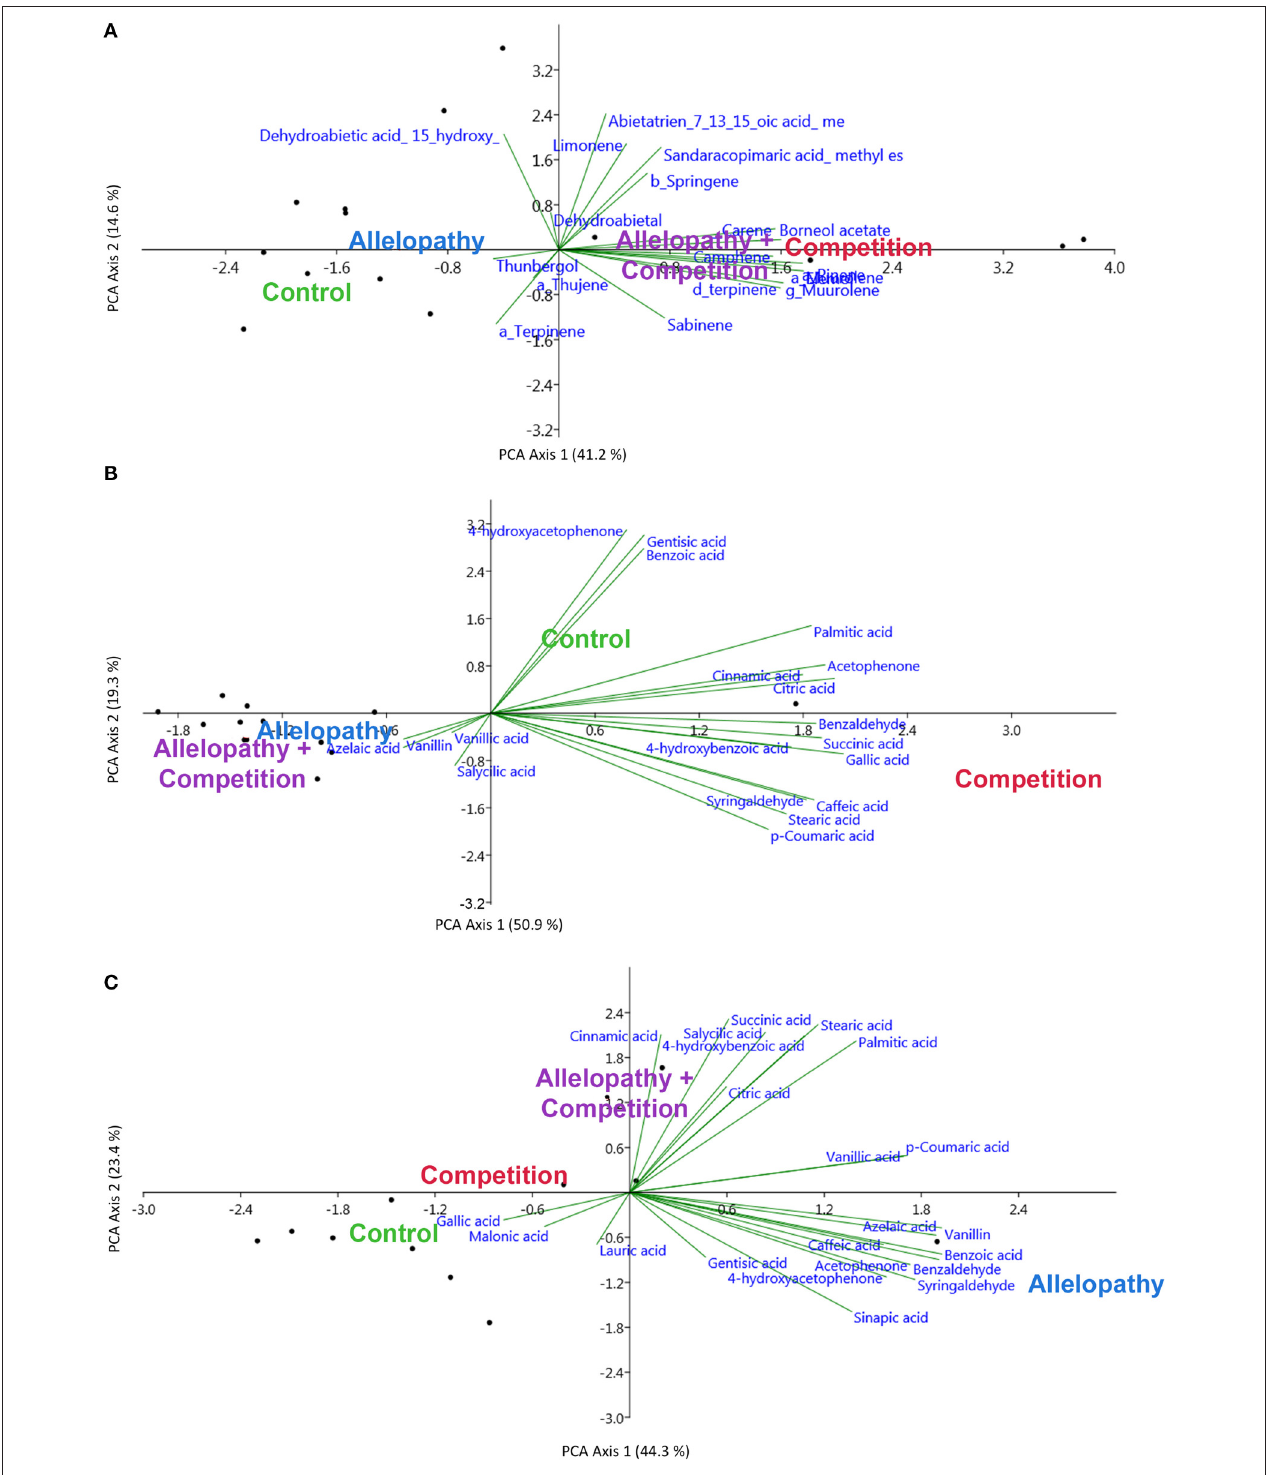
FIGURE 5 | Principal component analyses performed for metabolites most closely associated with responses to A, C, and AC (SIMPER analysis), for terpenoids for Pinus (A) and for polar metabolites in Pinus (B) and Quercus (C).